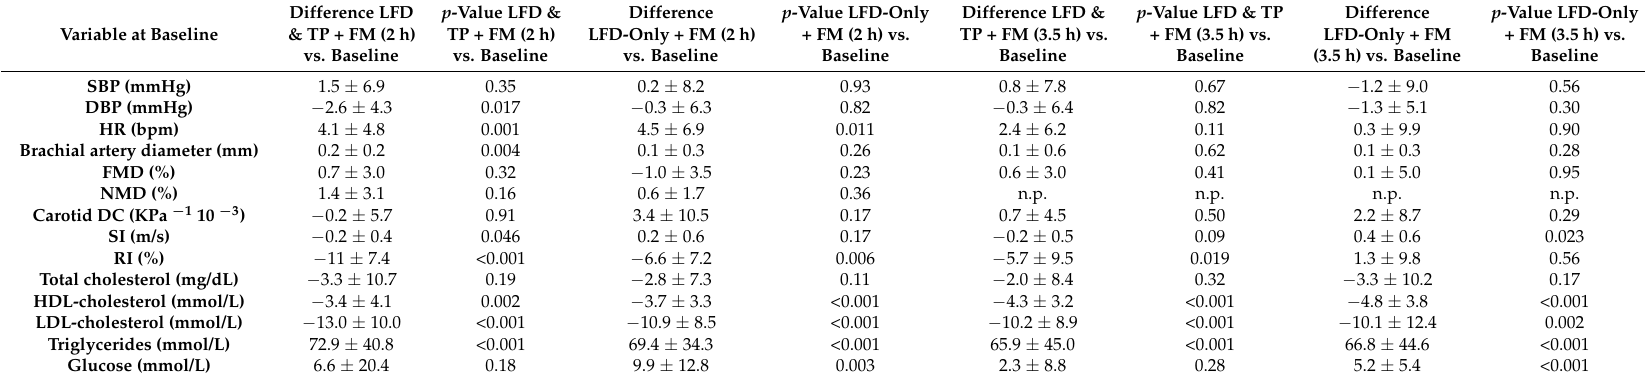
Table 2. Difference with respect to baseline of BP, vascular exams and metabolic parameters after 2 and 3.5 h from a fat meal ± tomato paste (LFD and TP + FM vs. LFD-only + FM ) in healthy young men.